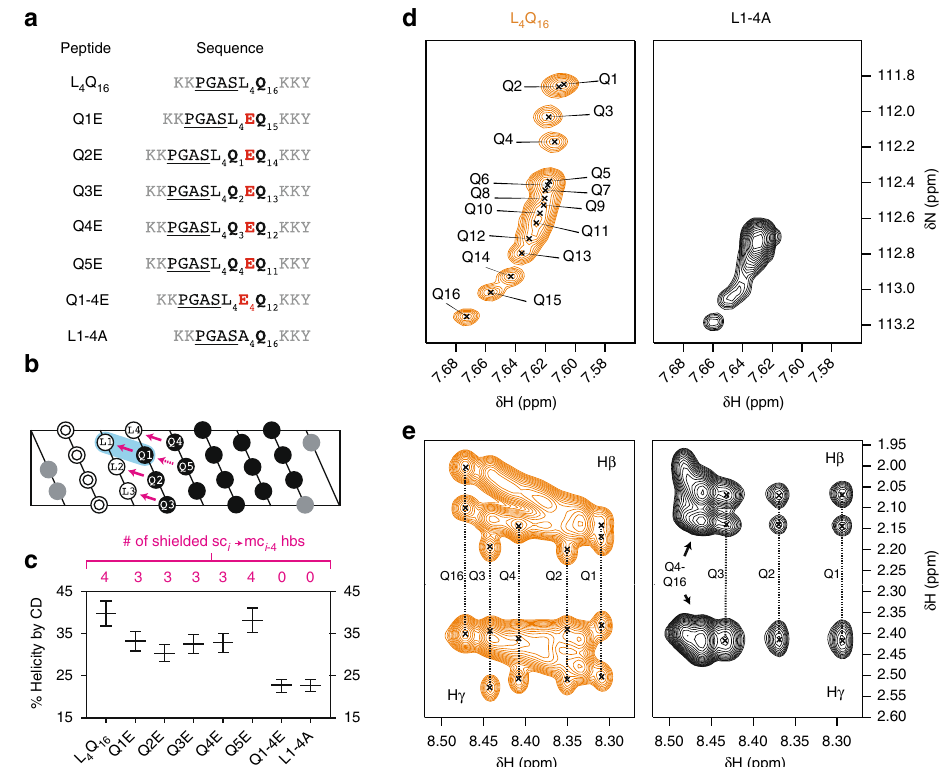
Fig. 5 The sc( i ) → mc( i - 4) hydrogen bonds stabilize polyQ helices. a Peptides used to determine the contribution of sc( i ) → mc( i − 4) hydrogen bonds to the stability of helical secondary structures and the effect of shielding. b Projection of the fully helical structure of peptide L 4 Q 16 in the color code used in a , where Lys residue areas are shown in gray, double circles represent the PGAS N-capping motif, Leu residues are displayed in white, and Gln residues in black, with an indication of the sc( i ) → mc( i − 4) hydrogen bonds in purple and of the shielding of the hydrogen bond between residues Q1 and L1 by the side chain of L1, as a blue shade. One unshielded, weaker hydrogen bond between Q1 and Q5 is represented by a dashed purple arrow. c Helicity of the peptides listed in a as determined by circular dichroism (CD) at pH 7.4 and 277 K, with an indication of the number of shielded hydrogen bonds that can occur in each peptide according to the model shown in b . The vertical bars represent the values of helicity obtained after scaling the experimental spectra by factors 0.9 and 1.1 to account for experimental error in the determination of peptide concentration. d Regions of the 1 H, 15 N heteronuclear single quantum correlation (HSQC) spectrum, measured at pH 7.4 and 278 K, of peptides L 4 Q 16 (see also Fig. 2b) and L1-4A containing the H ε 21 side chain resonances. e Region of the total correlation spectroscopy (TOCSY) spectrum of peptides L 4 Q 16 and L1-4A measured at pH 7.4 and 278 K illustrating the β and γ 1 H resonances of the Gln side